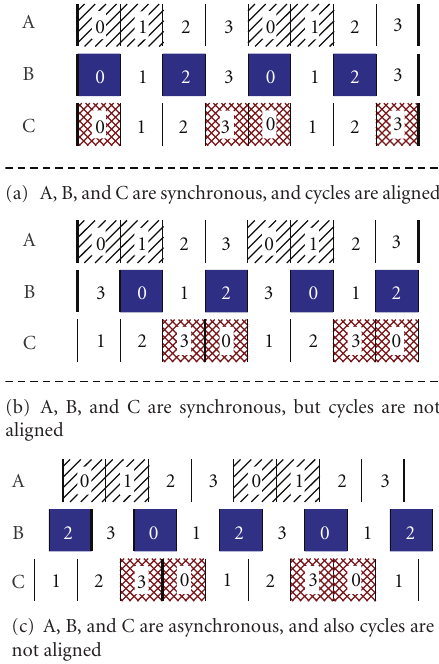
Figure 2: Synchronous and asynchronous PS nodes’